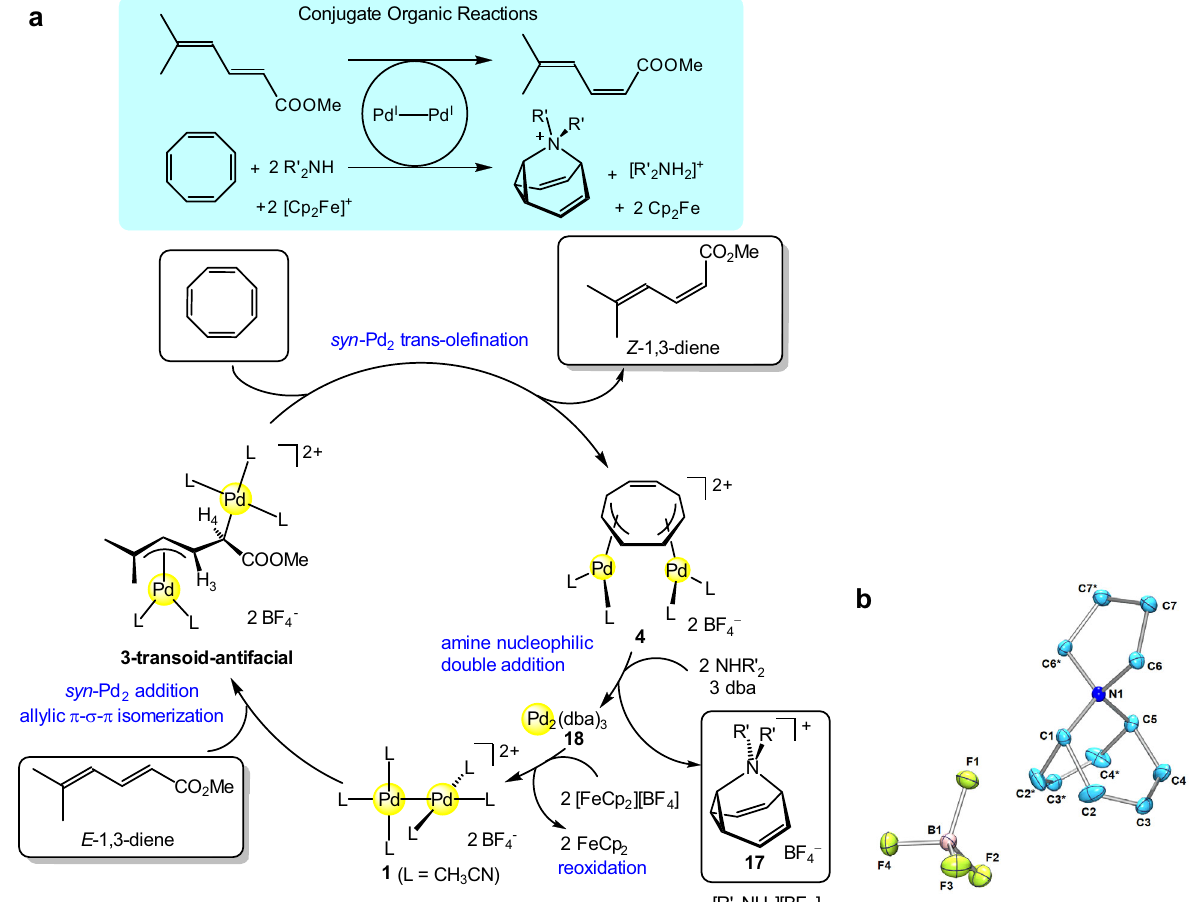
Fig. 4 The conjugate reaction system for the uphill E to Z isomerization. a E to Z isomerization of 1,3-diene is energetically coupled with oxidative double amination of cyclooctatetraene. The reaction conditions: CH 3 CN, 0 °C, 2 h, for 4 to 18 ; CH 3 CN/CH 2 Cl 2 , r.t., 1 h for 18 to 1 . b ORTEP for 17 (30% probability